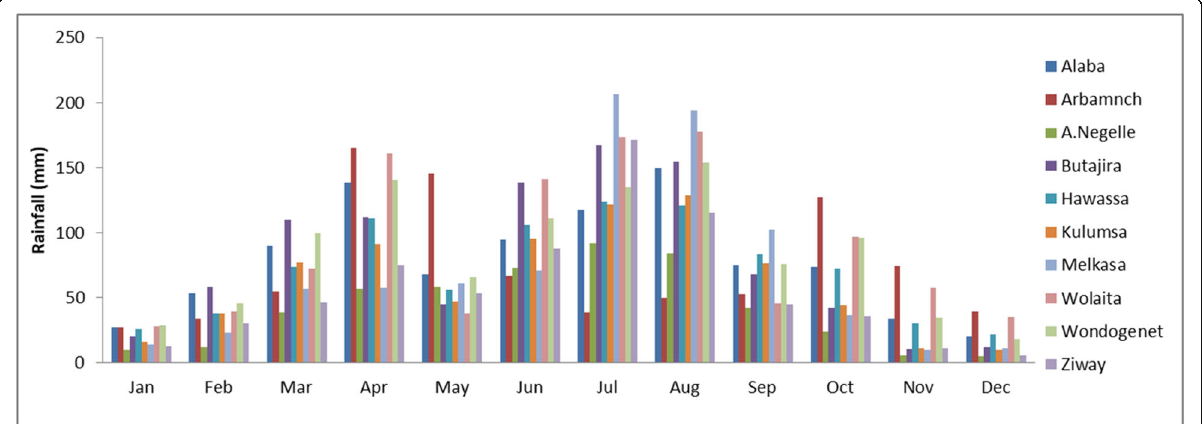
Fig. 3 Precipitation regime of the study